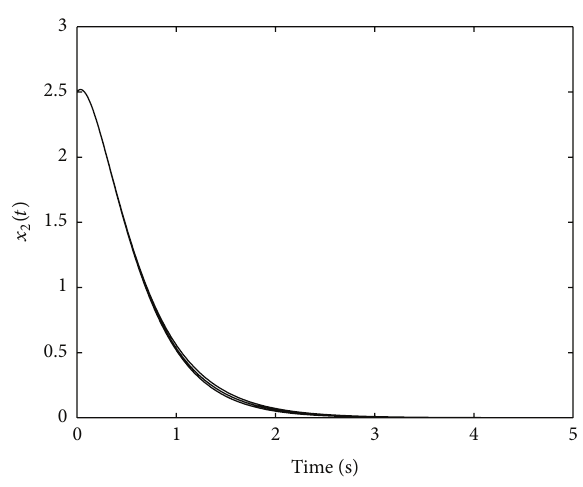
Figure 2: Evolution of the state variable 𝑥 2 (𝑡)